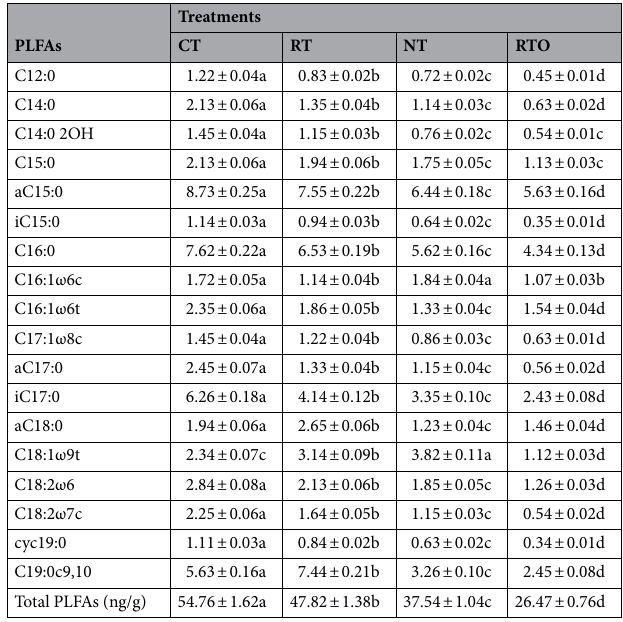
Table 2. Effects of different tillage management on soil phospholipid fatty acids content in a double-cropping rice field. Different lowercase letters in the same line were indicated significantly difference at p < 0.05 level. The same as below.